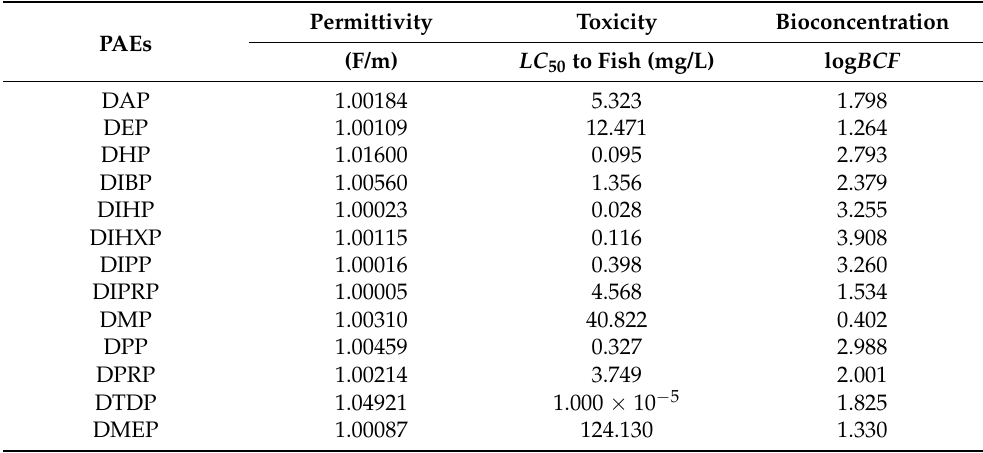
Table 1. Parameters of insulativity, toxicity, and bioconcentration of 13 PAEs. Permittivity Toxicity Bioconcentration PAEs (F/m) LC 50 to Fish (mg/L) log BCF DAP